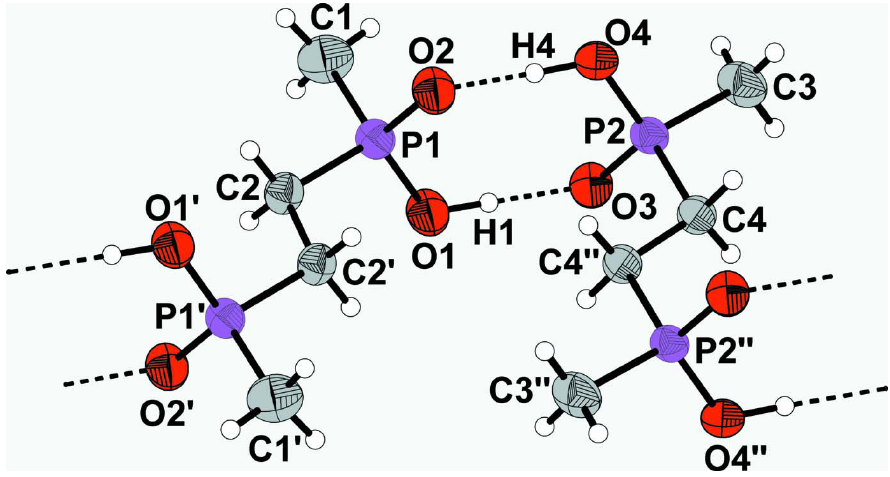
Figure 1 Part of the hydrogen bonded chain of the title structure. (displacement ellipsoids at the 50% probability level, H-atoms drawn with arbitrary radius, ′ = - x , 1 - y , 2 - z ; ′′ = 1 - x , 1 - y , 1 - z ) Ethane-1,2-diylbis(methylphosphinic acid) Crystal